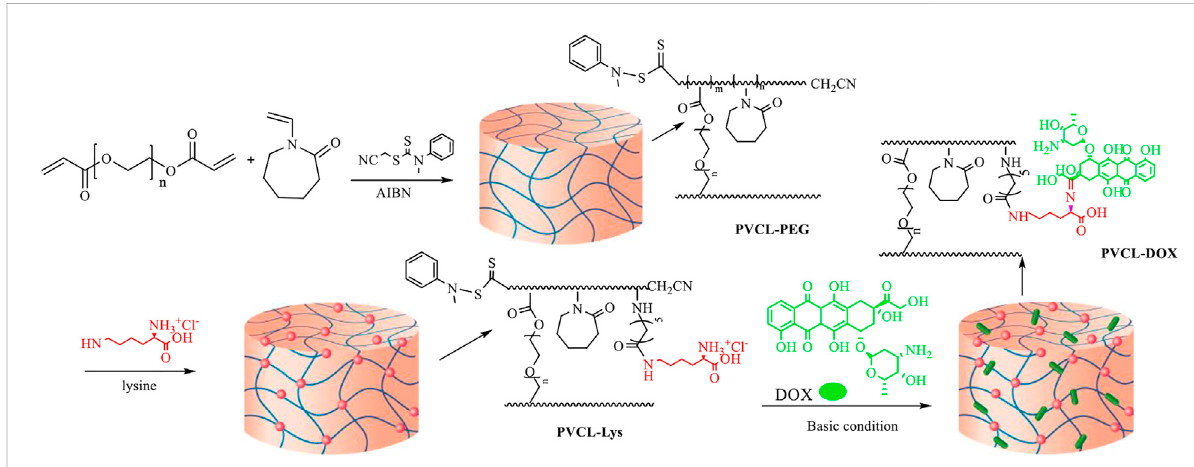
FIGURE 4 Synthetic strategy in forming PVCL-DOX NG (Farjadian et al., 2019b). No permission is